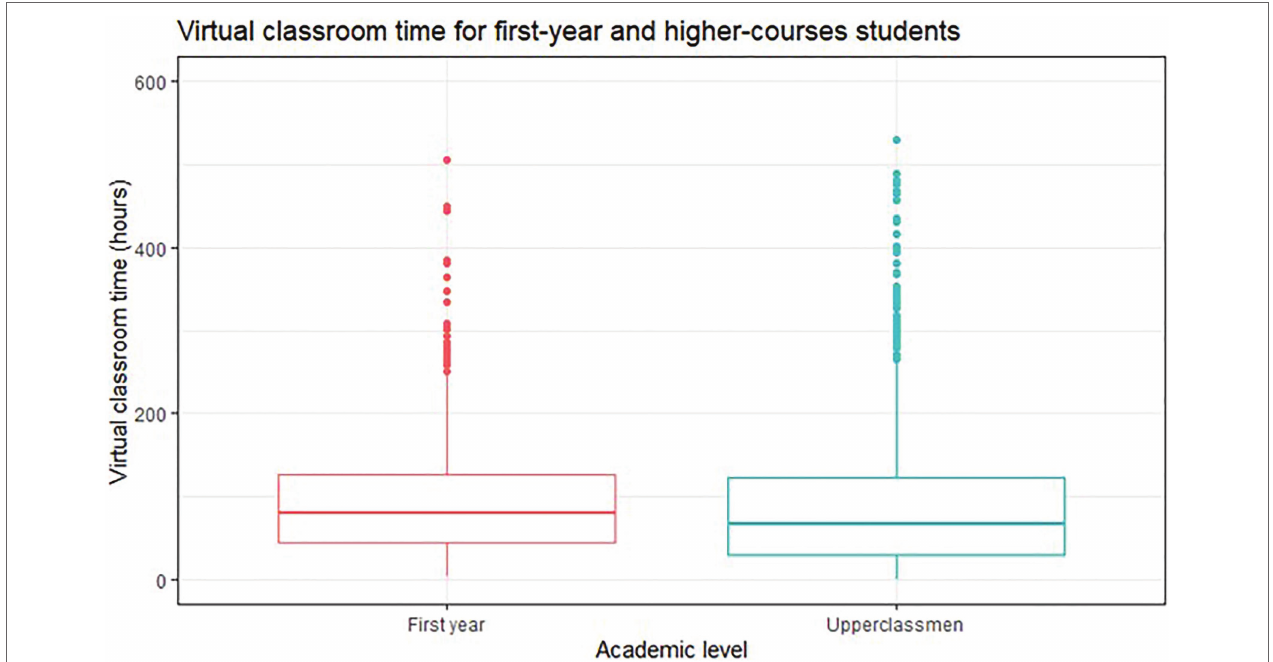
FIGURE 2 | Distribution of students’ connection time to the Learning Management systems (LMS) during the emergency remote teaching (ERT) semester according to their academic level.